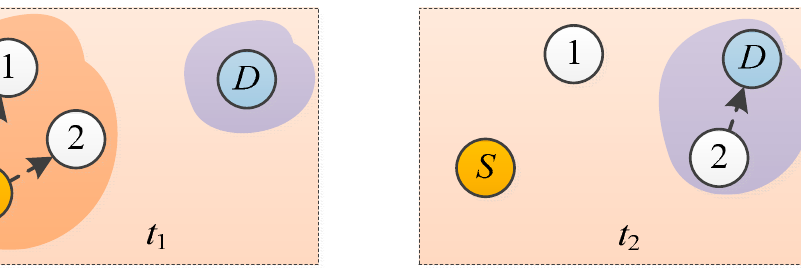
Figure 6. Communication of opportunistic networks.